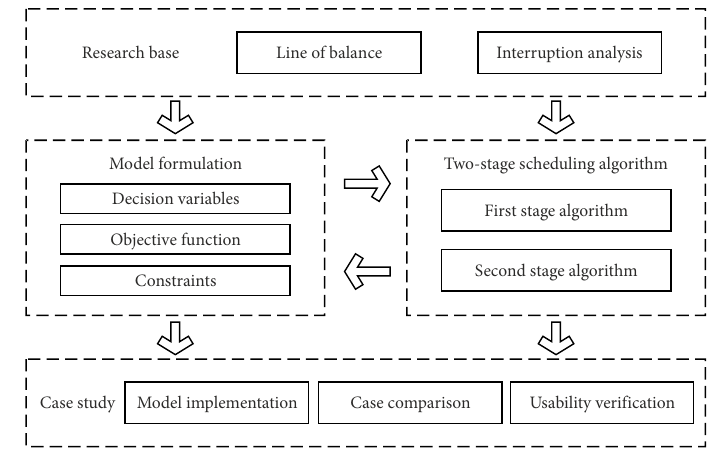
Figure 1. Research